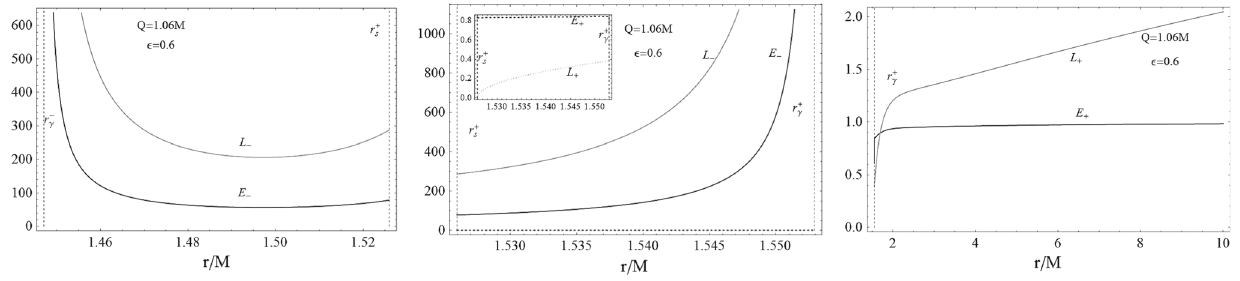
√ √ Fig. 20 Class : ( 3 6 / 7 ) M ≤ Q ≤ 9 / 8 M and (cid:9)(cid:9) (cid:2) − < (cid:2) < (cid:9)(cid:9) (cid:2) + . tum L = L + ( gray curve ) and energy E = E + ( black curve ) in r − γ < r < r + s ( left plot ); L = L ± in r + s ≤ r < r + γ ( center plot ); Parameter choice is as follows: Q = 1 . 06 M and (cid:2) = 0 . 6. Then (cid:9)(cid:9) (cid:2) (cid:9)(cid:9) (cid:2) + = 1 . 52596 M , r − = 1 . 44708 M , and L = L − in r ≥ r + γ ( right plot ) + = 0 . 618133, − = 0 . 536564, r γ s and r + γ = 1 . 55292 M . Circular orbits exist with angular momen-